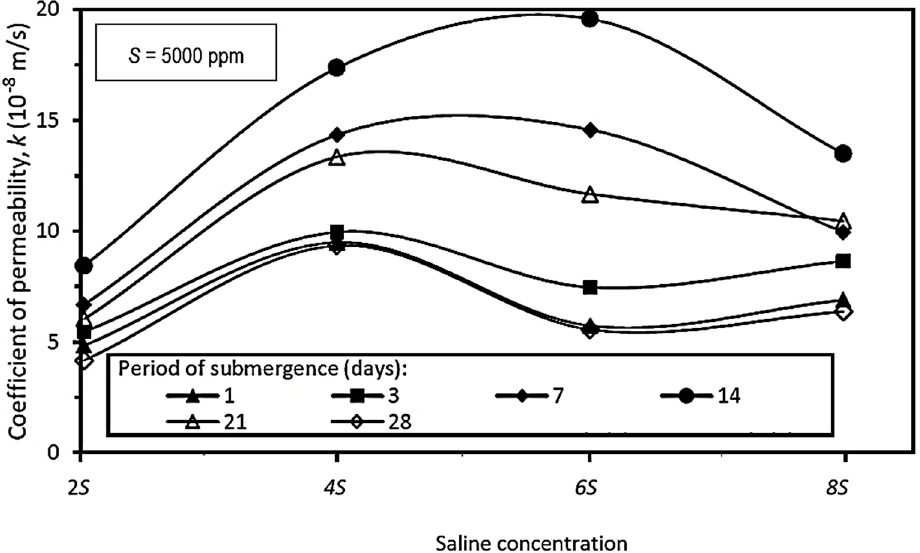
Figure 13. Variation of k with saline concentration.